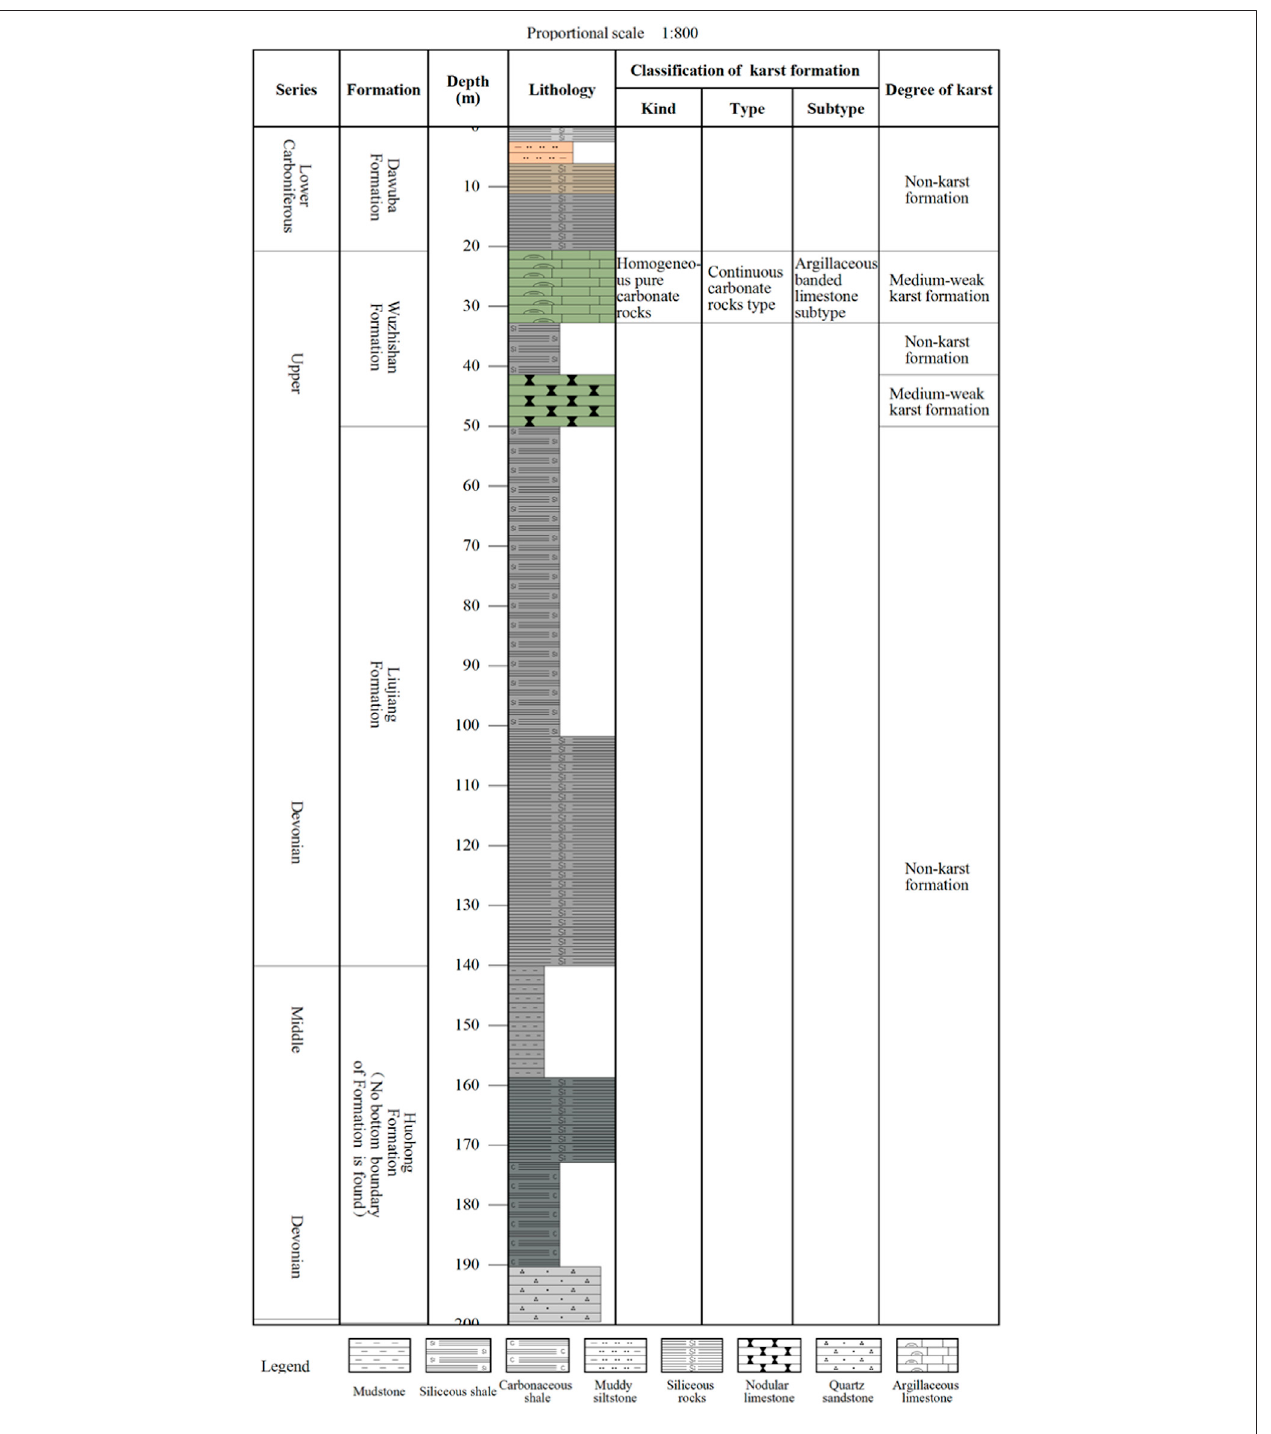
FIGURE 5 | Karst formation division of the Linna section of Luodian, Qiannan area.